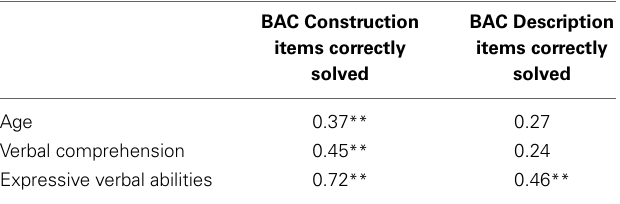
Table 4 | Correlation between items correctly solved and age, verbal comprehension and expressive verbal